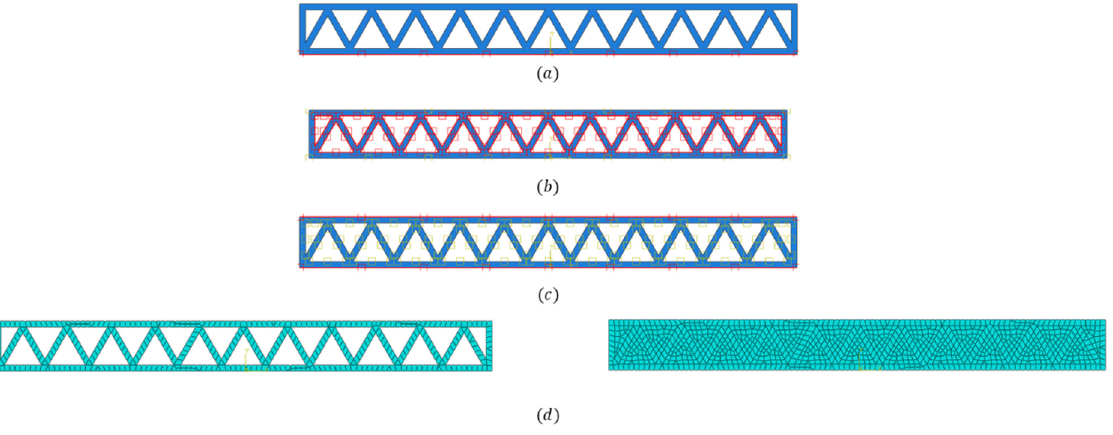
Figure 6. Abaqus modelling images: ( a ) boundary condition; ( b ) cavity radiation; ( c ) surface inter- action; ( d ) meshing.